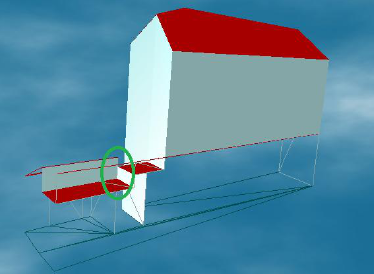
Figure 18. Two corner edges of two box shaped parts of a building touching each other at an